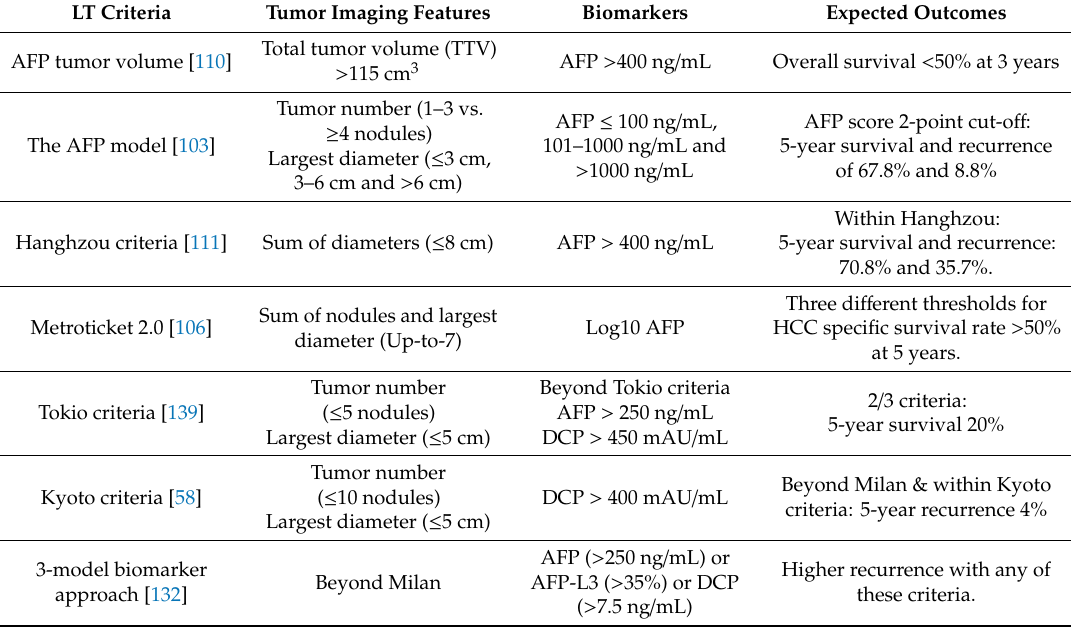
Table 4. Biomarkers used for liver transplantation selection criteria in patients with